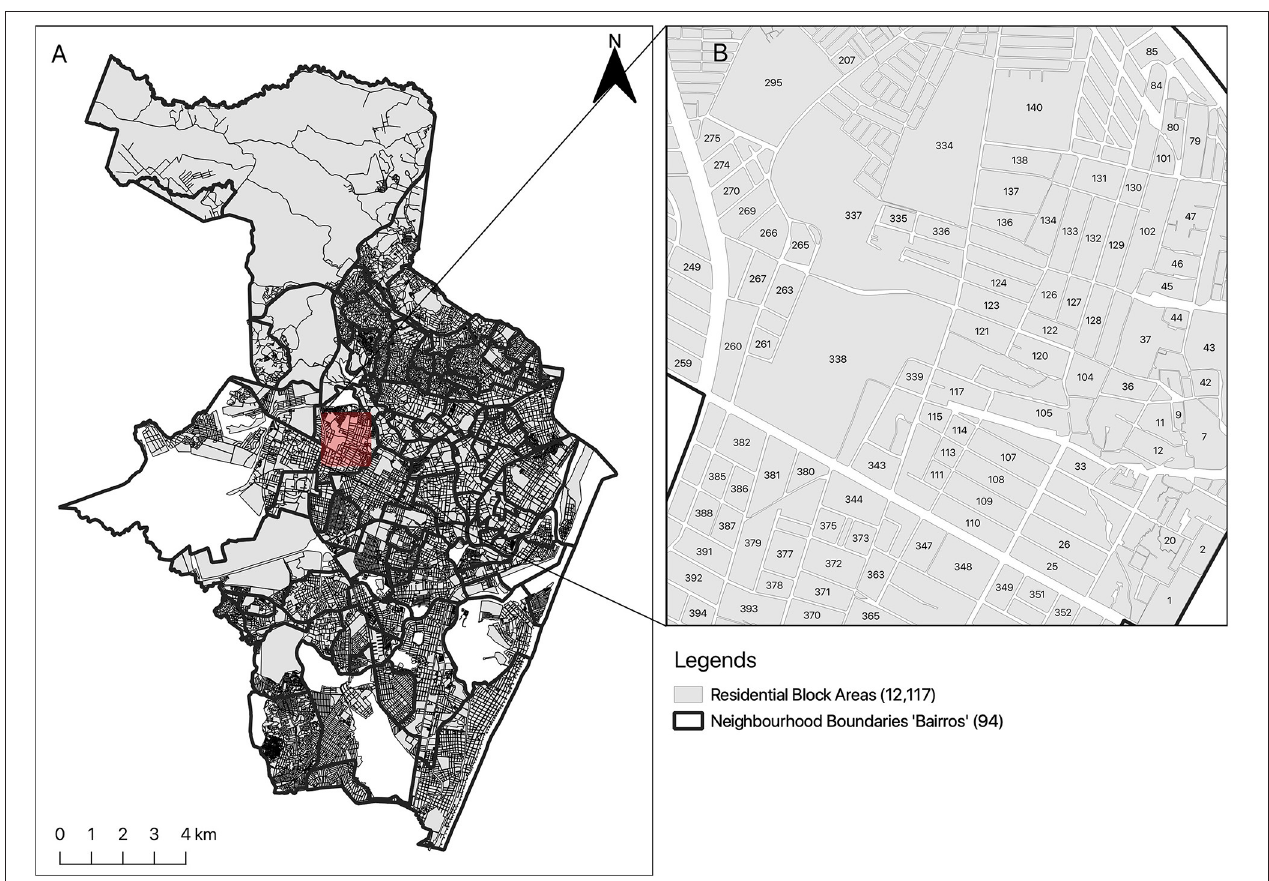
FIGURE 1 | The study area of Recife showing the spatial configuration of the neighborhoods (A) and block areas (B) .